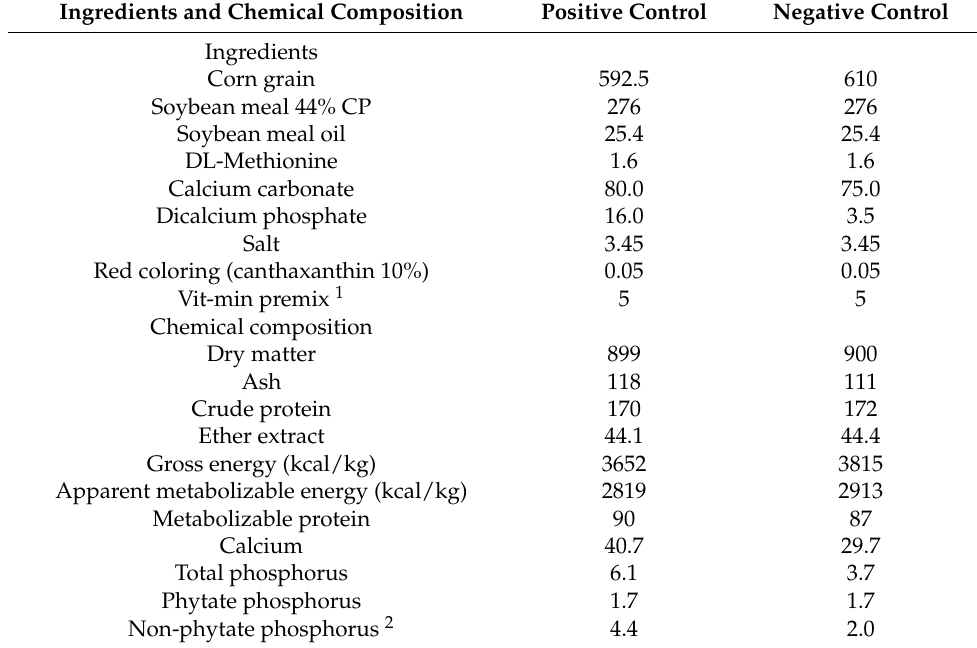
Table 1. Ingredients and chemical composition of the experimental diets (g/kg). Ingredients and Chemical